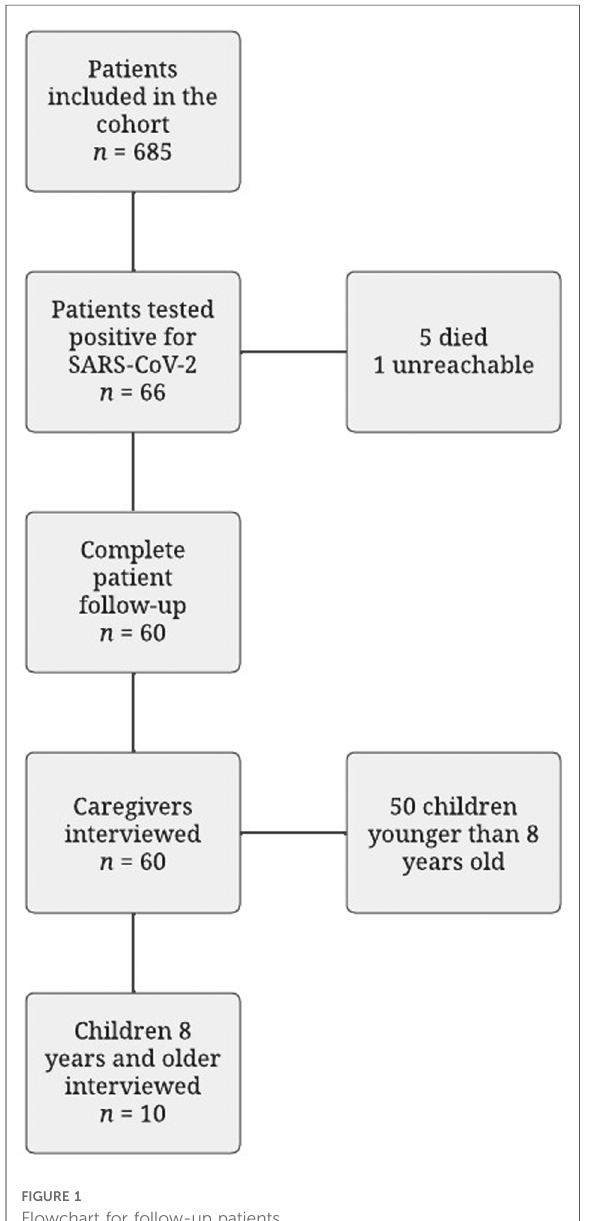
FIGURE 1 Flowchart for follow-up patients.